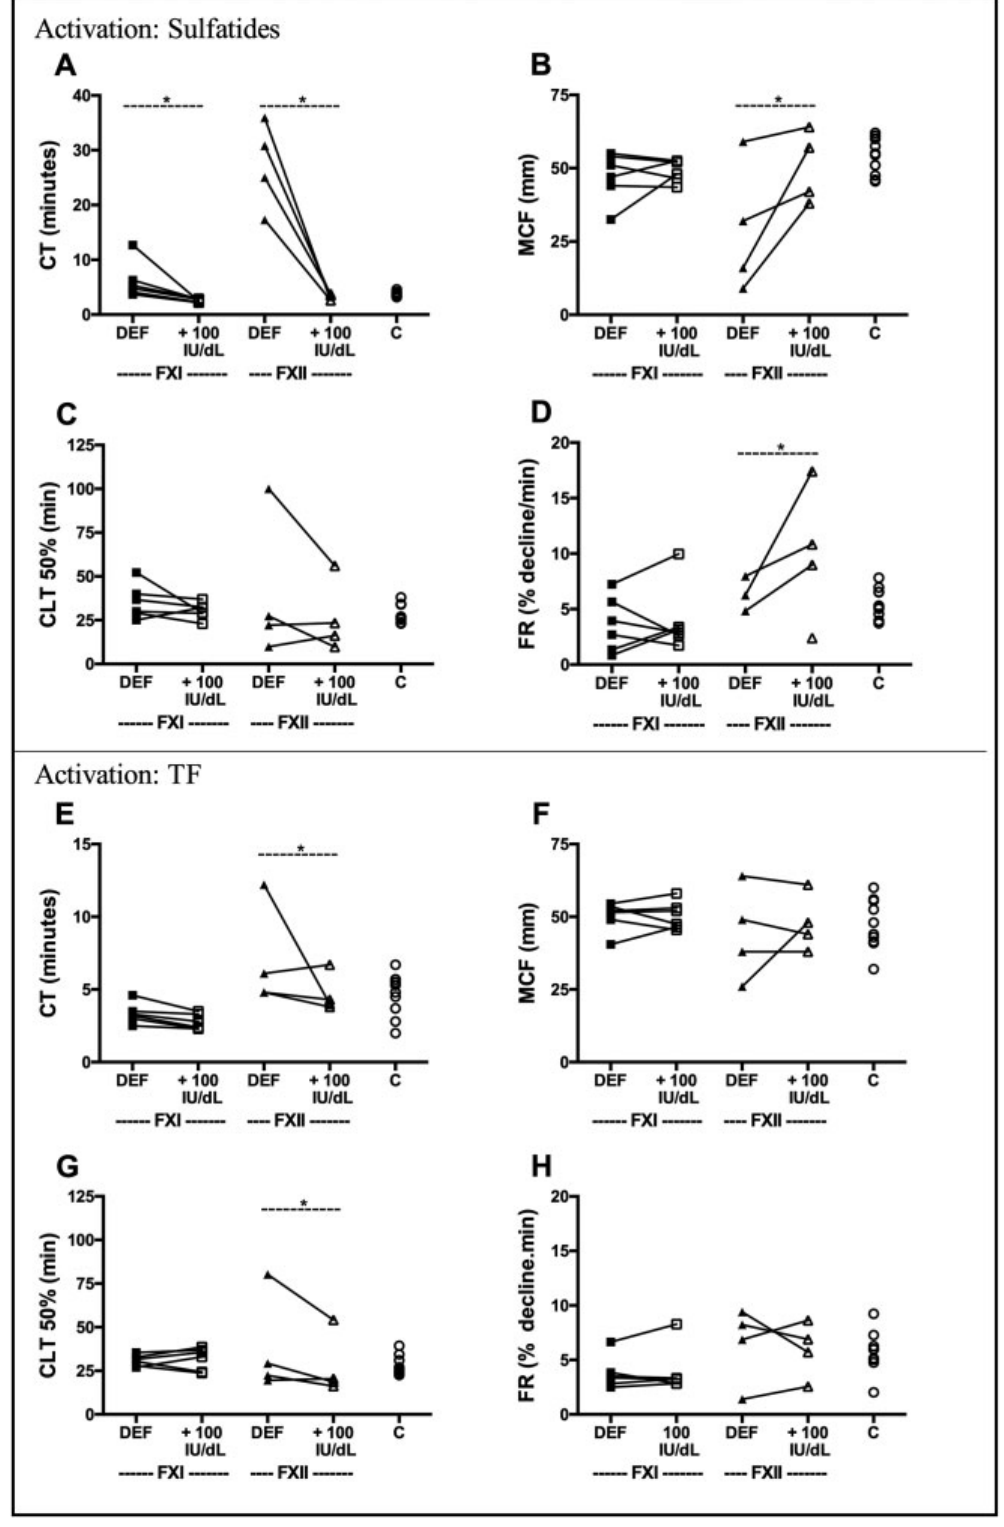
Fig. 2 Aberrant elastic clot formation in whole blood from patients normalized by factor addition. ROTEM curves were generated with whole blood from indicatedcontrols(C)orFXI-orFXII-de fi cientpatients.TriggeringwaswithCaCl 2 and4 μ mol/Lsulfatides( A – D ),orCaCl 2 and15pmol/LTF(CTI-treatedblood) ( E – H ). Where indicated, FXI (5.3 pmol in 340µL) or FXII (65 pmol in 340µL) was preadded to the blood leading to an increase in the endogenous FXI or FXII concentration of 100IU/dL. For one FXII-de fi cient patient, the fi brinolysis rate after sulfatide stimulation could not be calculated ( D ) since lysis velocity was extremelyslowandlessthan90%ofthethrombuswaslysedwithin2hoursofmeasurement.Thefollowingcurveparameterswereassessed:CT(clottingtime), MCF(maximalclot fi rmness),CLT(50%clotlysistime),FR( fi brinolysisrate). (cid:1) p < 0.05vs.nofactoraddition(Kruskal – WallisANOVA).CTI,corntrypsininhibitor; TF, tissue